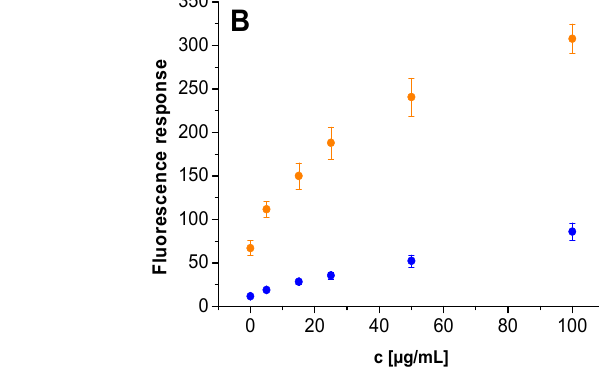
Figure 6. The dependence of fluorescence intensity on trypsin and chymotrypsin concentration after application of ITP ( A ) and ICP ( B ) anchored to Rink Amide PEGA resin. Immobilized probes (2.0 − 2.1 mg) were dispersed in Tris-HCl buffer (0.1 M; 1 mL) and incubated for 15 min at 37 °C. Fluorescence emission was measured at 480 nm ( ITP ) and 595 nm ( ICP ) after excitation at 410 nm (blue dots) and 554 nm (yellow dots). Detector voltage was set either to 600 V ( λ EXC = 410 nm) or 500 V ( λ EXC = 554 nm).